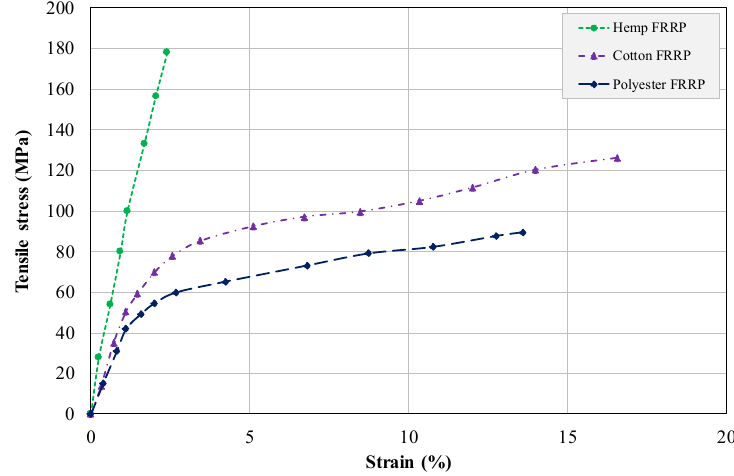
Figure 3. Tensile stress versus strain relationships of FRRP composites.